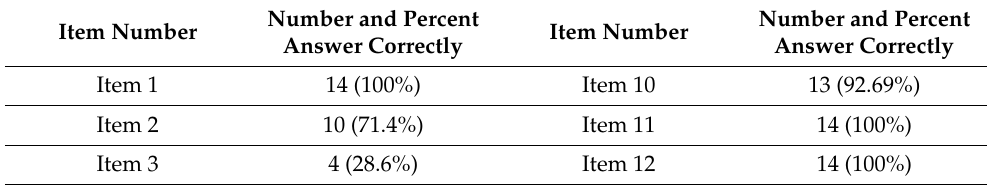
Table 3. Participants Answering OSAKA Knowledge Items Correctly ( n =